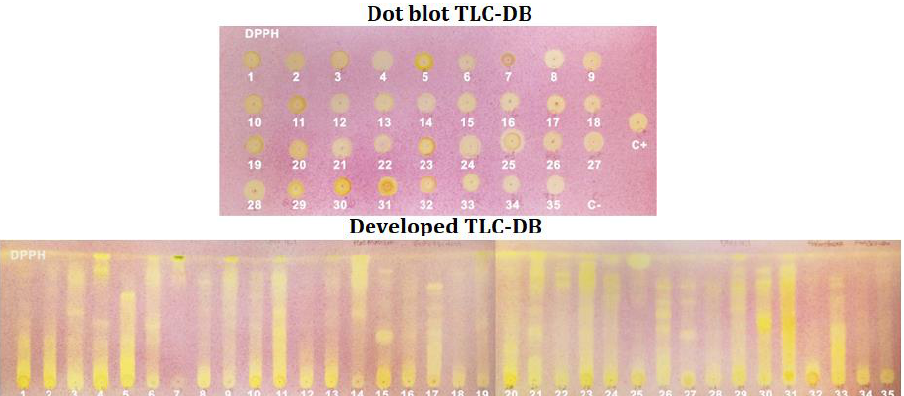
Figure 4. Qualitative antioxidant activity evaluation of Halmahera plant extracts using TLC direct bioautography method (TLC-DB) against DPPH. Dichloromethane-methanol with a ratio of 10:1 was used as the mobile phase for developed TLC-DB. The list of Halmahera plant extracts (number 1-35) (Table